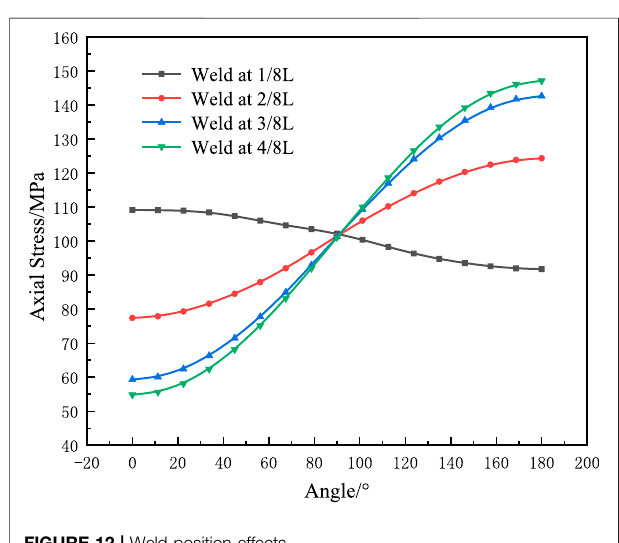
FIGURE 12 | Weld position